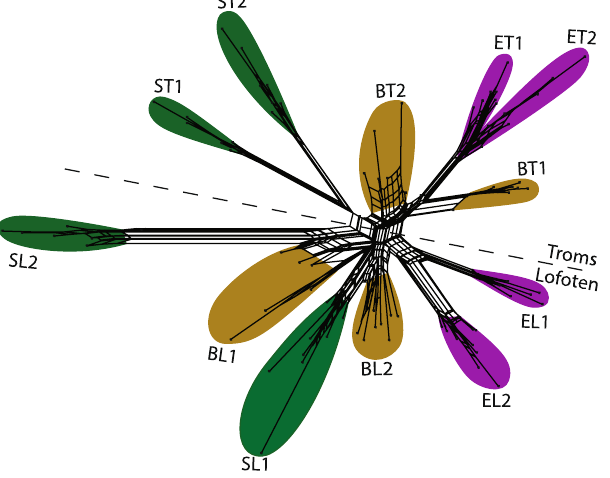
Figure 4. Neighbour net performed on 12 populations of Cochlearia officinalis , using 4,311 SNPs from the RADseq data. Colour represents ecotypes: beach - yellow, estuary - purple and spring - green. Populations are named according to ecotype (B = beach, E = estuary, S = spring) and geography (T = Troms, L = Lofoten), see Table 1. The dotted line indicates a geographical split between the two sampling areas, Troms and